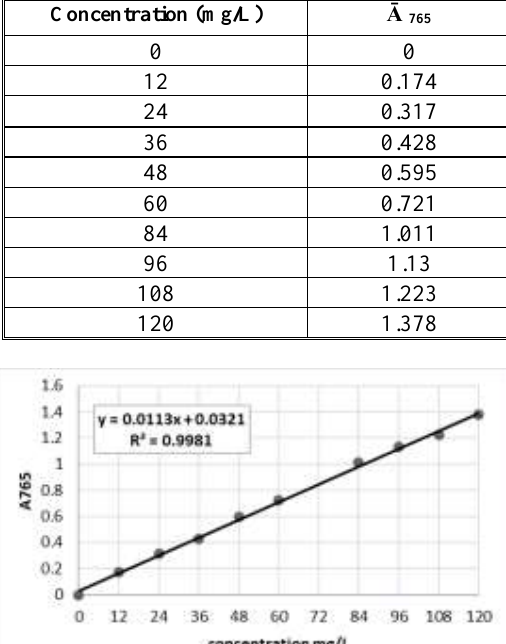
Table 3. Gallic acid concentrations and their